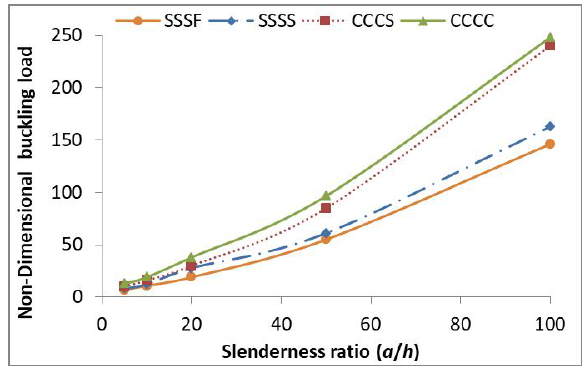
Fig. 5. Dimensionless buckling load of the FG plate PEEK - 30% CF with different BCs, skins height 2 mm, k =0.5 and β =0.1.